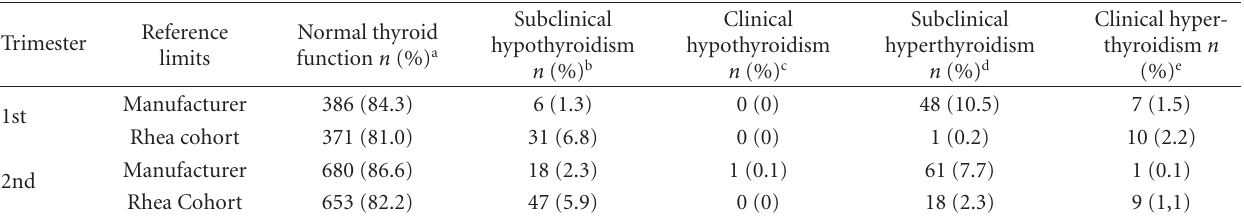
Table 4: Thyroid clinical entities in the general population of Rhea mother-child cohort based on: (i) the manufacturer’s and (ii) the derived reference